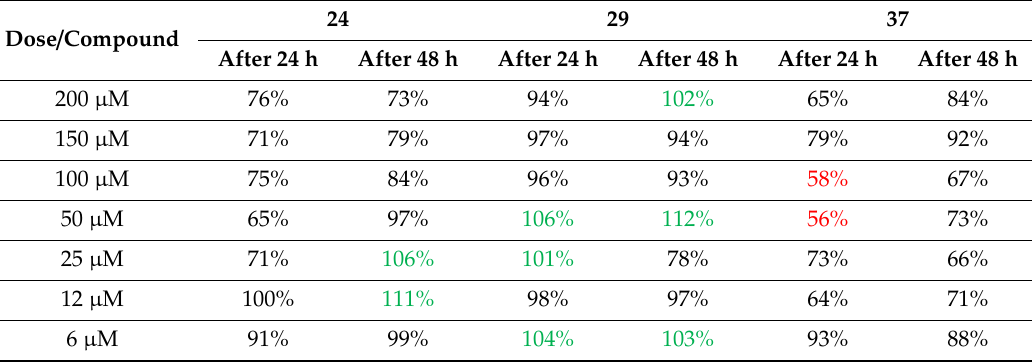
Table 4. The cell proliferation in % according to control after 24 h and after 48 h exposition on studied compounds in A549 cell line .